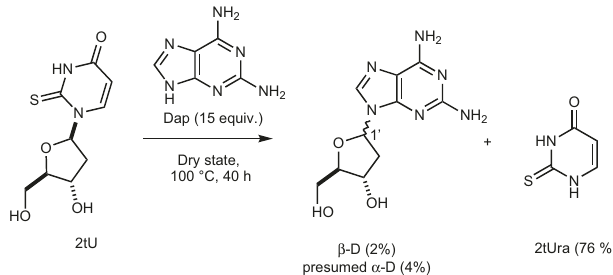
Fig. 5 Transglycosylation reaction of 2 ′ -deoxy-2-thiouridine (2tU) furnishing 2,6-diaminopurine 2 ′ -deoxyriboside (D). Transglycosylation of 2tU in the dry state with D gives a mixture of α and β stereoisomers of the D deoxyriboside alongside loss of the 2tUra